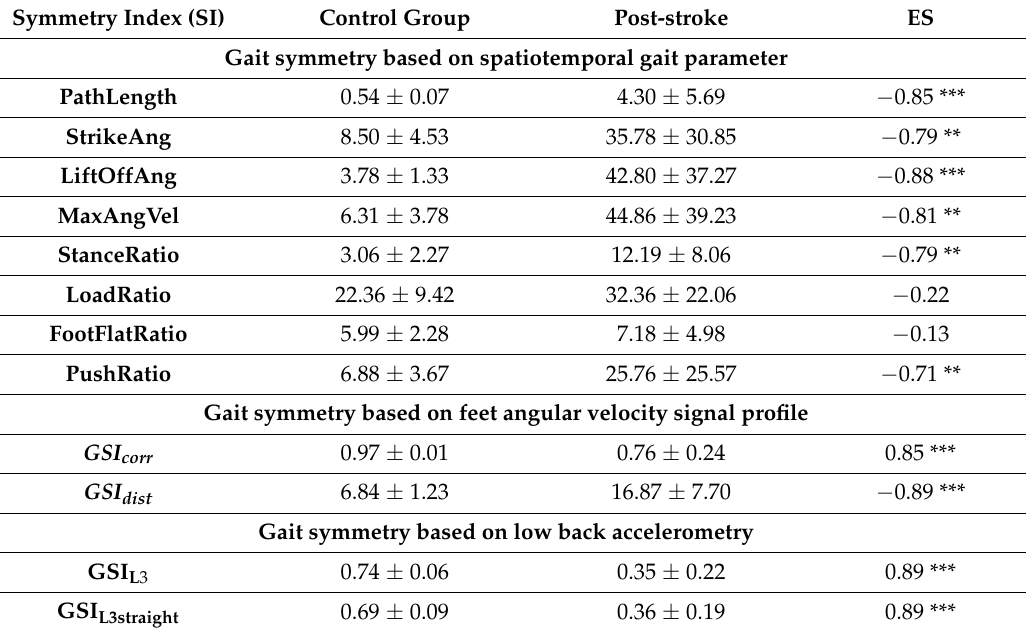
Table 2. Mean ± standard deviation and effect size (ES) as estimated by Cliff’s Delta of various symmetry indices.